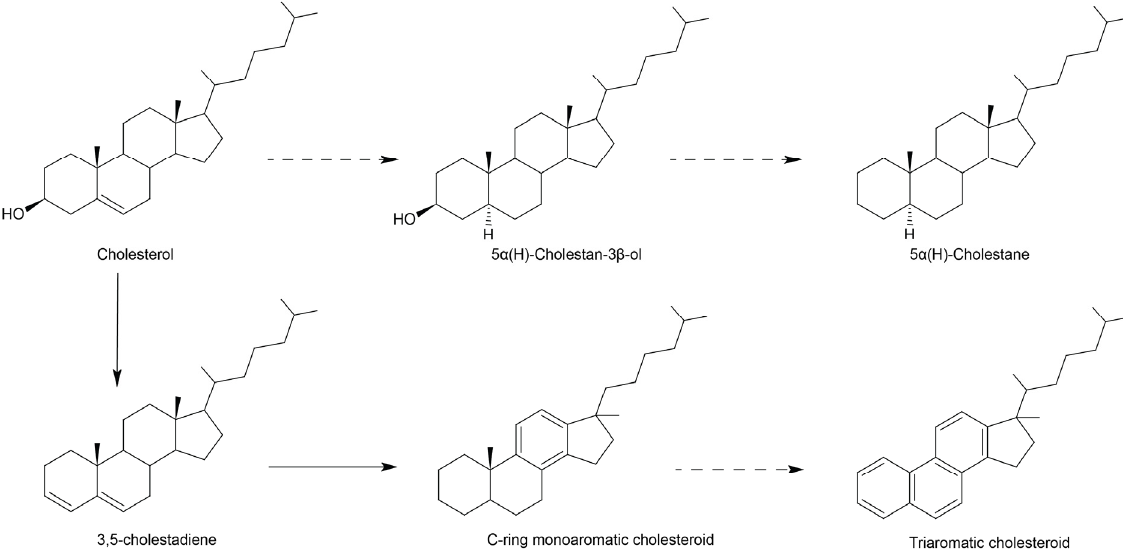
Figure 6. General schematic demonstrating diagenetic rearrangements of cholesteroid compounds, as identified in fossil coprolites in the current study. Dashed lines represent multiple possible intermediates or pathways.In both fossil and matrix of all samples, n -alkanes are abundant and consistently range from n -C 15 to n -C 26 with a maximum at n -C 23 but with no odd or even carbon number preference (Figure 7). The predominance of mid-chain (C 20 -C 25 ) n -alkanes and lack of high-molecular-weight n -alkanes supports input from aquatic organic material in a limnic or deltaic environment receiving a minimal input of land plant material, e.g., [91,92]. The freshwater-influenced n -alkane distribution is thus in agreement with a geologically inferred large delta setting, e.g., [41–45]. The regular isoprenoids pristane (Pr) and phytane (Ph) are also present with Pr/Ph ratios ranging from 0.85–1.65 (Table 2), ratios supporting fluctuating redox conditions within the environment